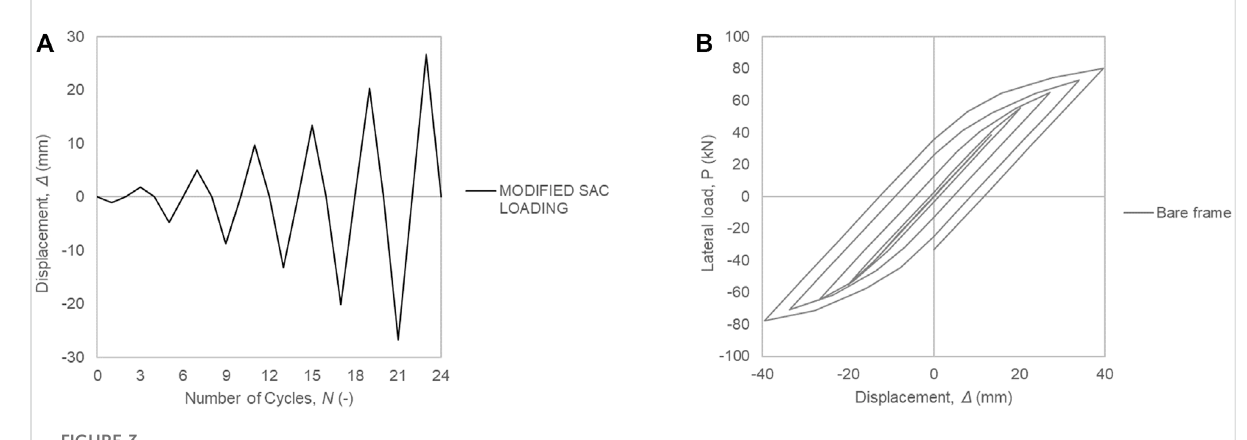
FIGURE 3 (A) Loading history, (B) Hysteretic curve of bare